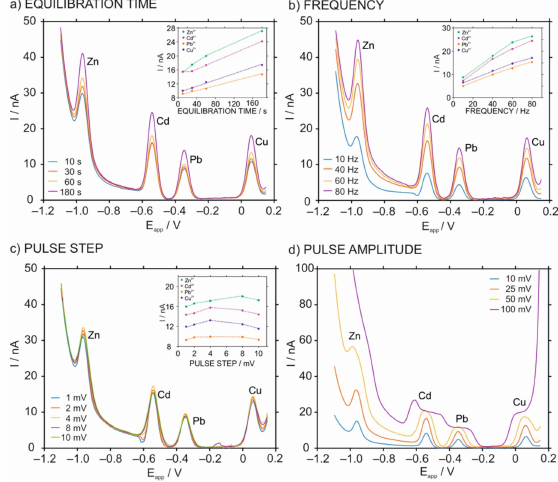
Figure 4. Influence of ( a ) the equilibration time in the stripping voltammogram for 50 nM Zn 2+ , Cd 2+ , Pb 2+ , and Cu 2+ in 0.01 M NaNO 3 / HNO 3 (pH 2.0) background solution. Influence of ( b ) frequency, ( c ) pulse step and ( d ) pulse amplitude used for the SWASV step in the stripping voltammogram for 50 nM Zn 2+ , Cd 2+ , Pb 2+ , and Cu 2+ in 0.01 M NaNO 3 / HNO 3 (pH 2.0) background solution. Insets: peak current after data baseline correction while varying the parameter under study.